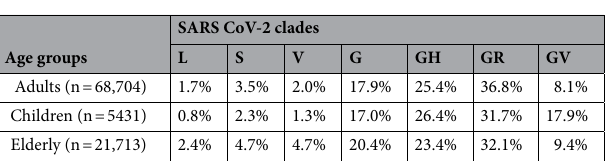
Table 5. Age groups distribution of SARS-CoV-2 clades.